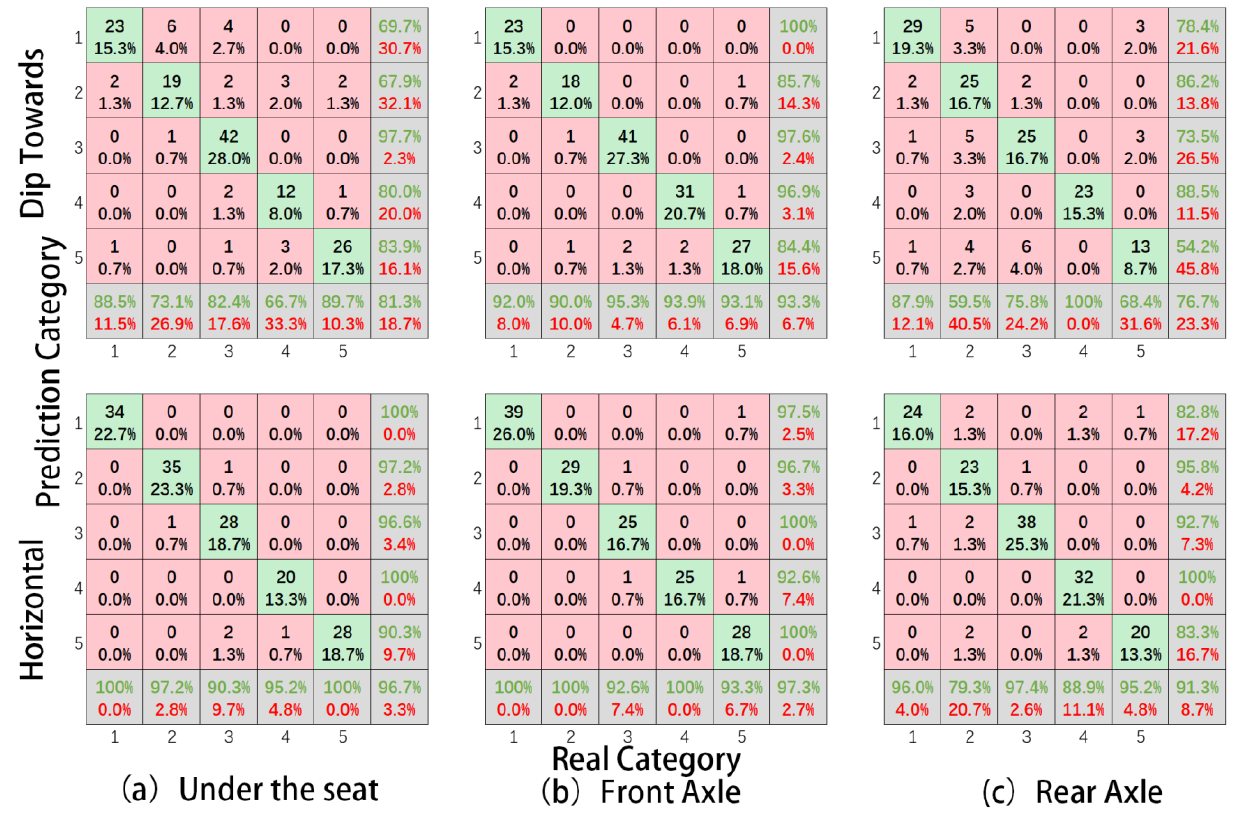
Figure 11. Random forest confusion matrices.